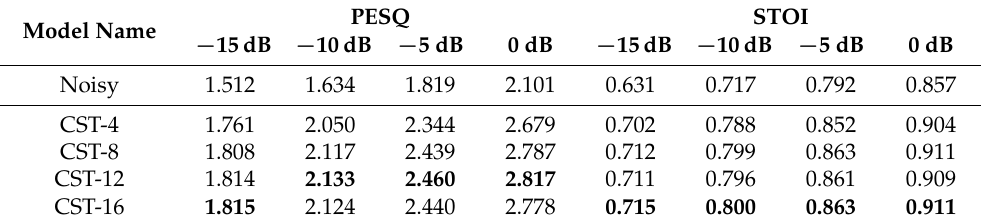
Table 4. Effect of different layers in the MUSAN test set.